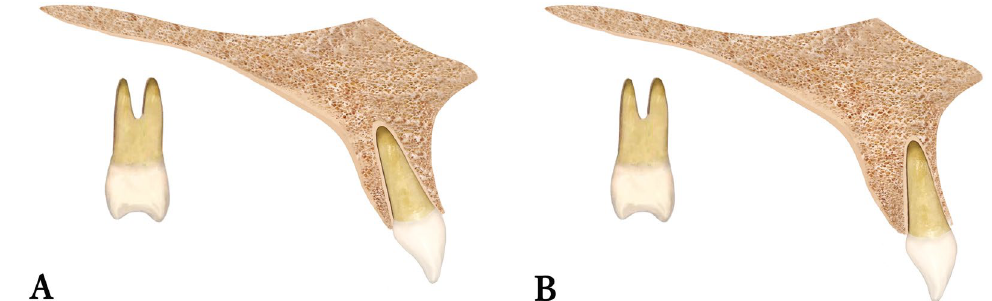
Fig. 2 Estimated post‑treatment inclination of upper incisors in fixed appliance group ( A ) and clear aligners group ( B